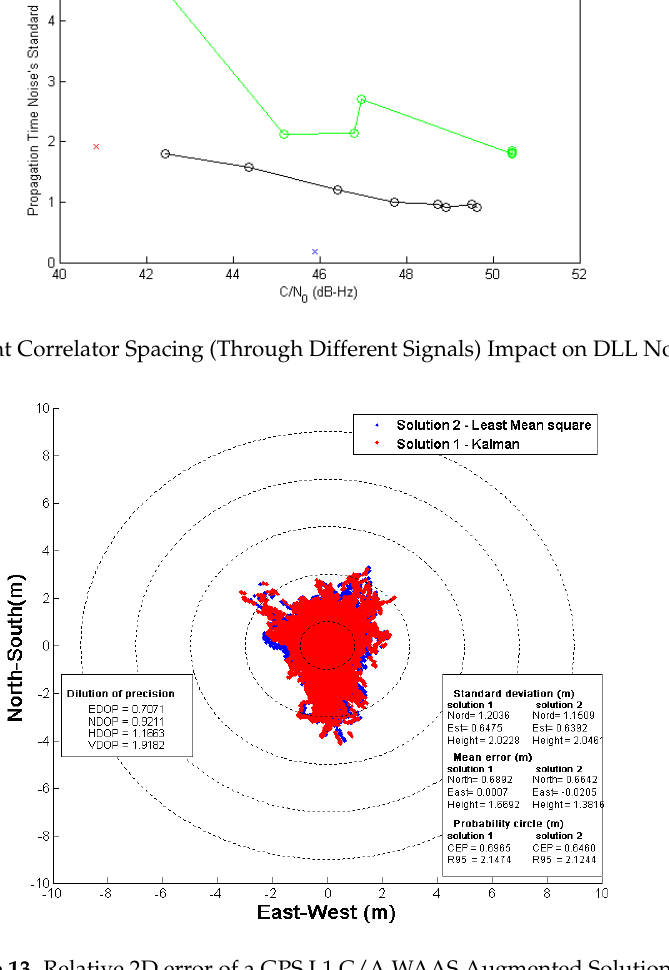
Figure 13. Relative 2D error of a GPS L1 C/A WAAS Augmented Solution.